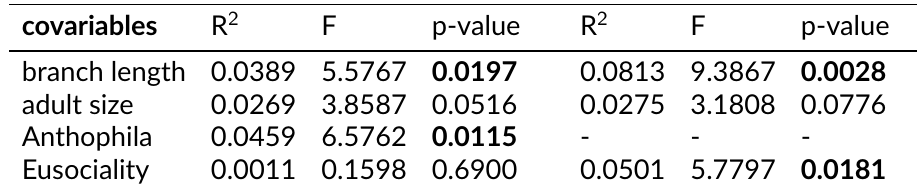
Table S2 – Linear modelling of uncorrected dN/dS ratios. Displayed results are obtained when simultaneously using all covariables inside a multiple linear model. Phylogenetic independent contrasts are used for all variables so as to account for phylogenetic auto- correlation.